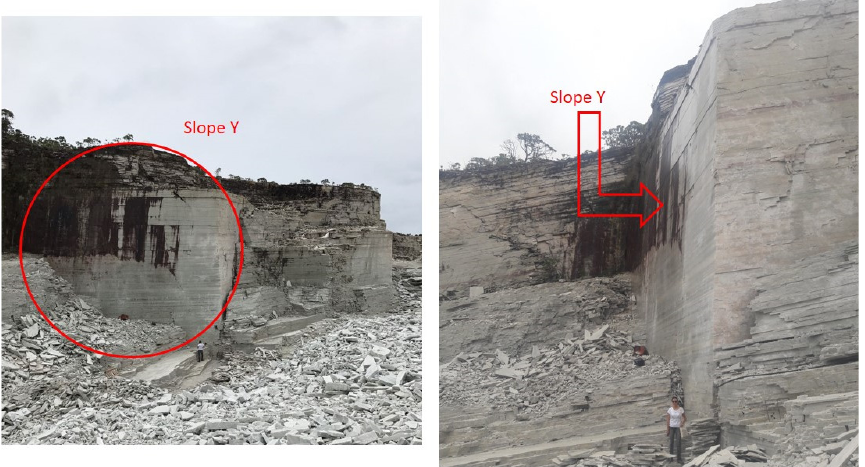
Figure 9. Slope Y.